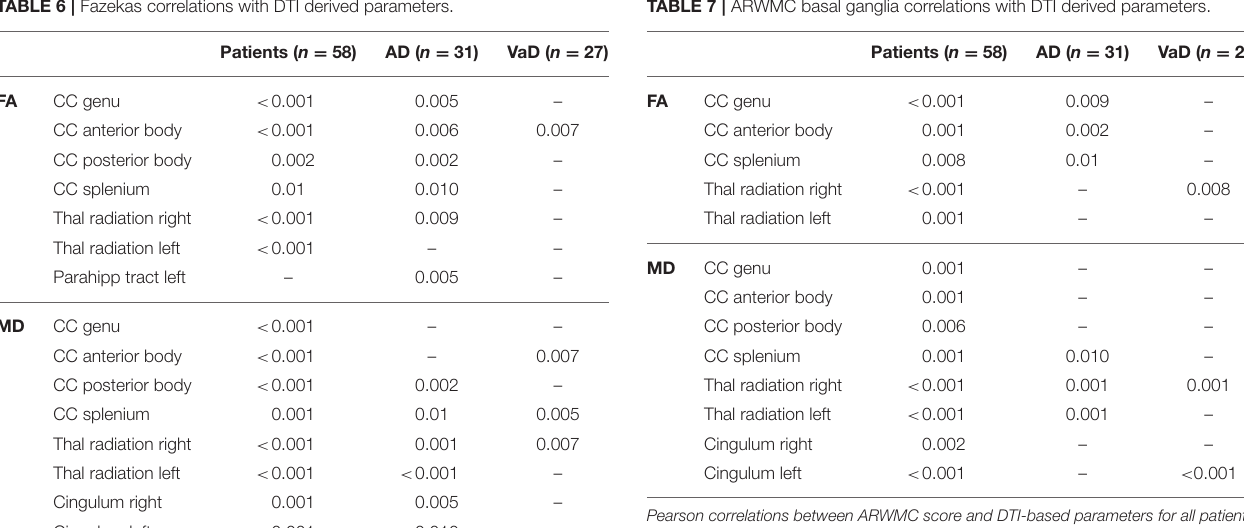
TABLE 6 | Fazekas correlations with DTI derived parameters. TABLE 7 | ARWMC basal ganglia correlations with DTI derived